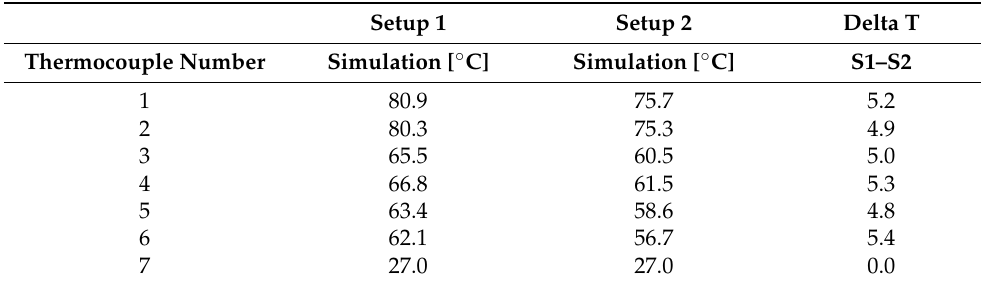
Table 9. Simulations temperature for Setup 1 and Setup